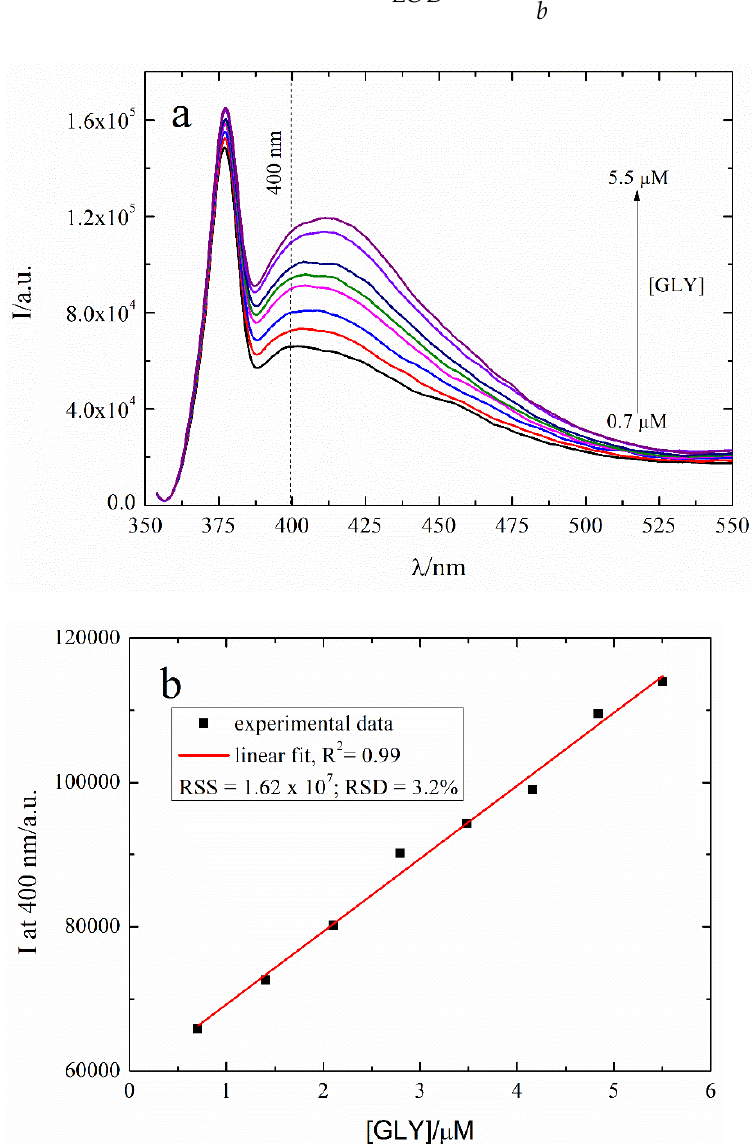
Figure 1. ( a ) Emission spectra ( λ exc = 340 nm) of [Cu(opba)] 2 − (0.2 mM) after successive additions of 10 µ L aliquots of aqueous GLY (177 µ M). ( b ) Analytical curve for the emission (I) of [Cu(opba)] 2 − as a function of GLY